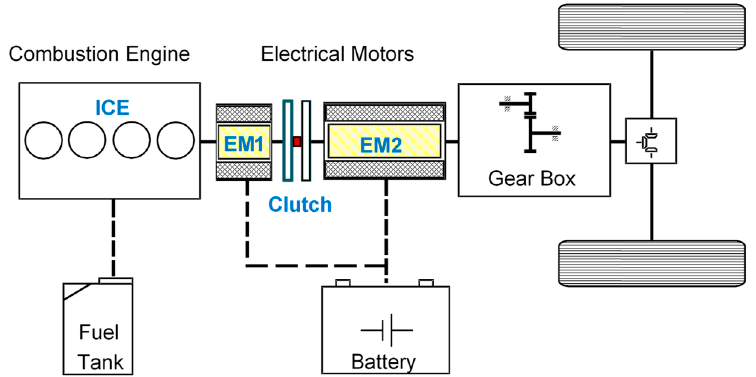
Figure 1. HEV parallel powertrain scheme.